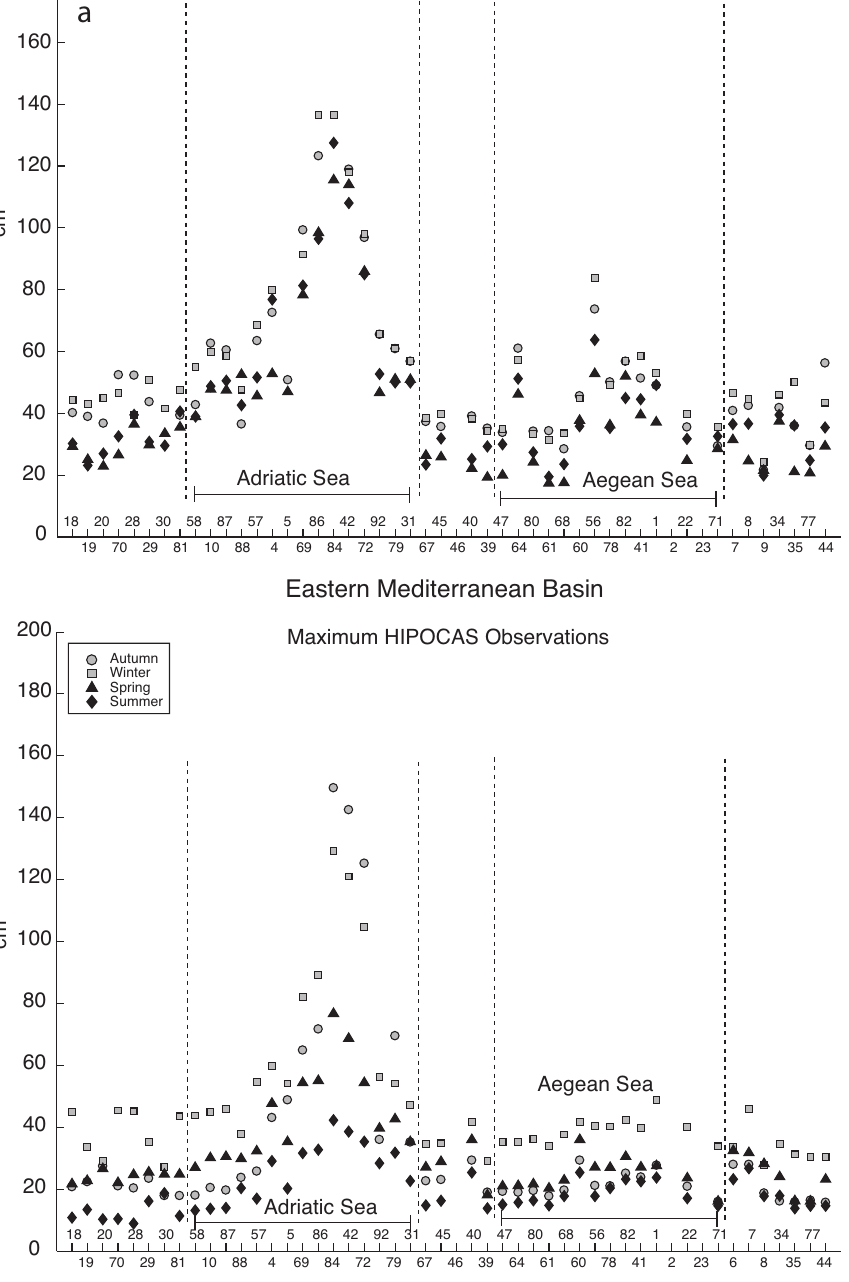
Figure 5. As Figure 3 for the eastern Mediterranean tide-gauges.